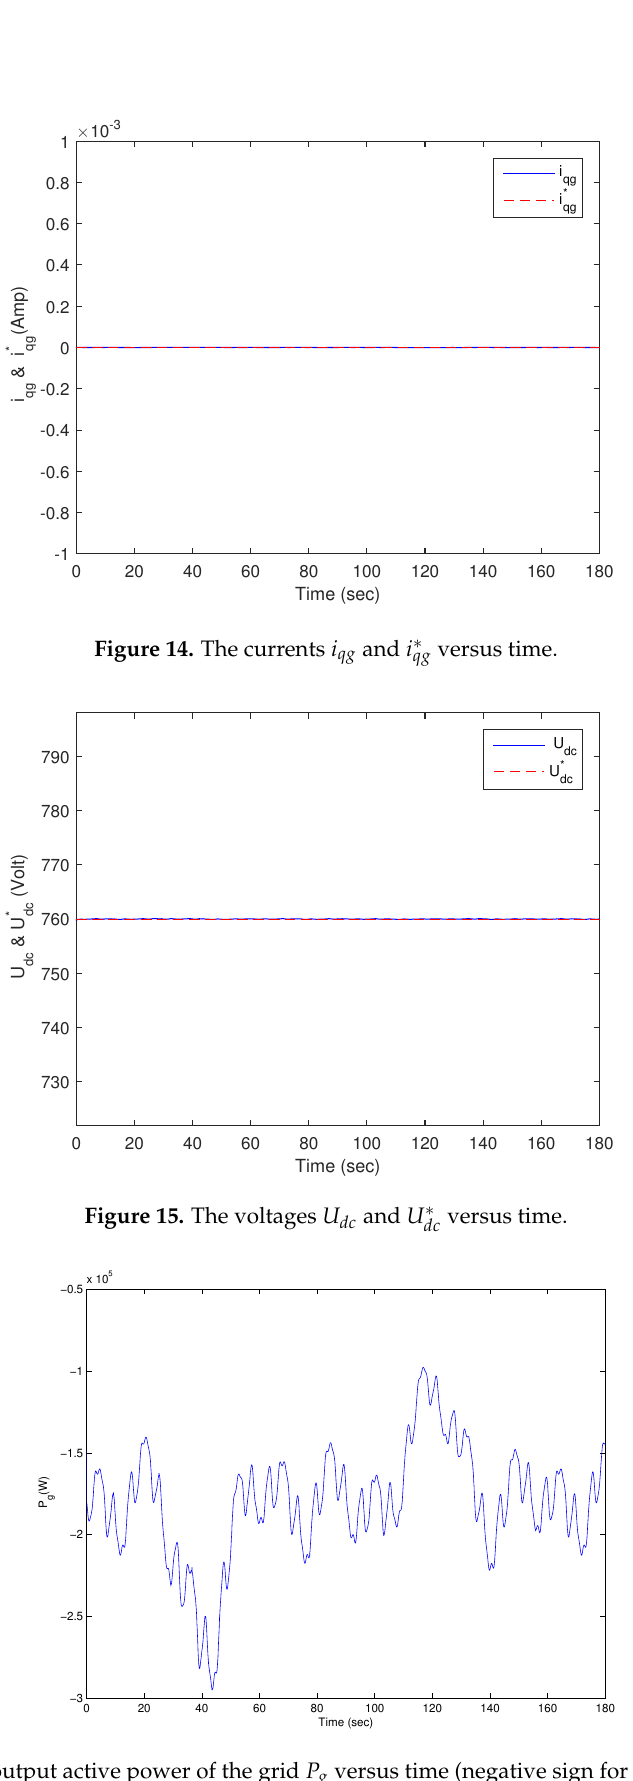
Figure 16. The output active power of the grid P g versus time (negative sign for produced